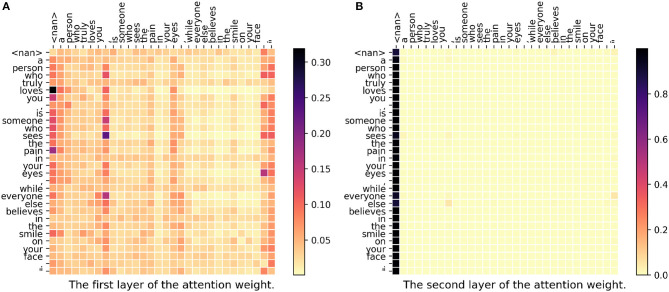
(A,B) The attention weight matrix of our model. <nan> is the padding term since the word length is <30. In this case, the correct city is kisumu-07-ke but DeepGeo, CNN, FUJIXEROX, and the proposed method predict lagos-05-ng, lagos-05-ng, quezon city-ncrf2-ph, and kano-29-ng respectively.